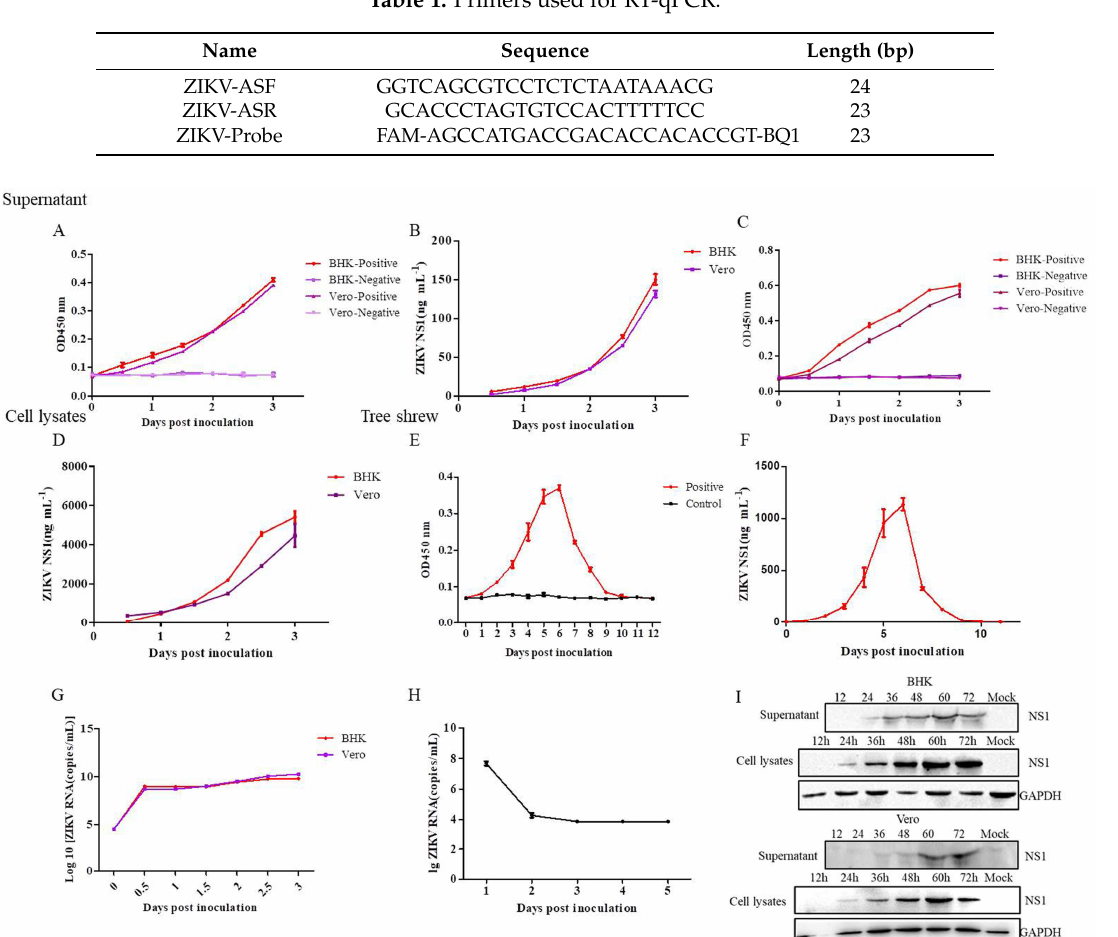
Table 1. Primers used for RT-qPCR.